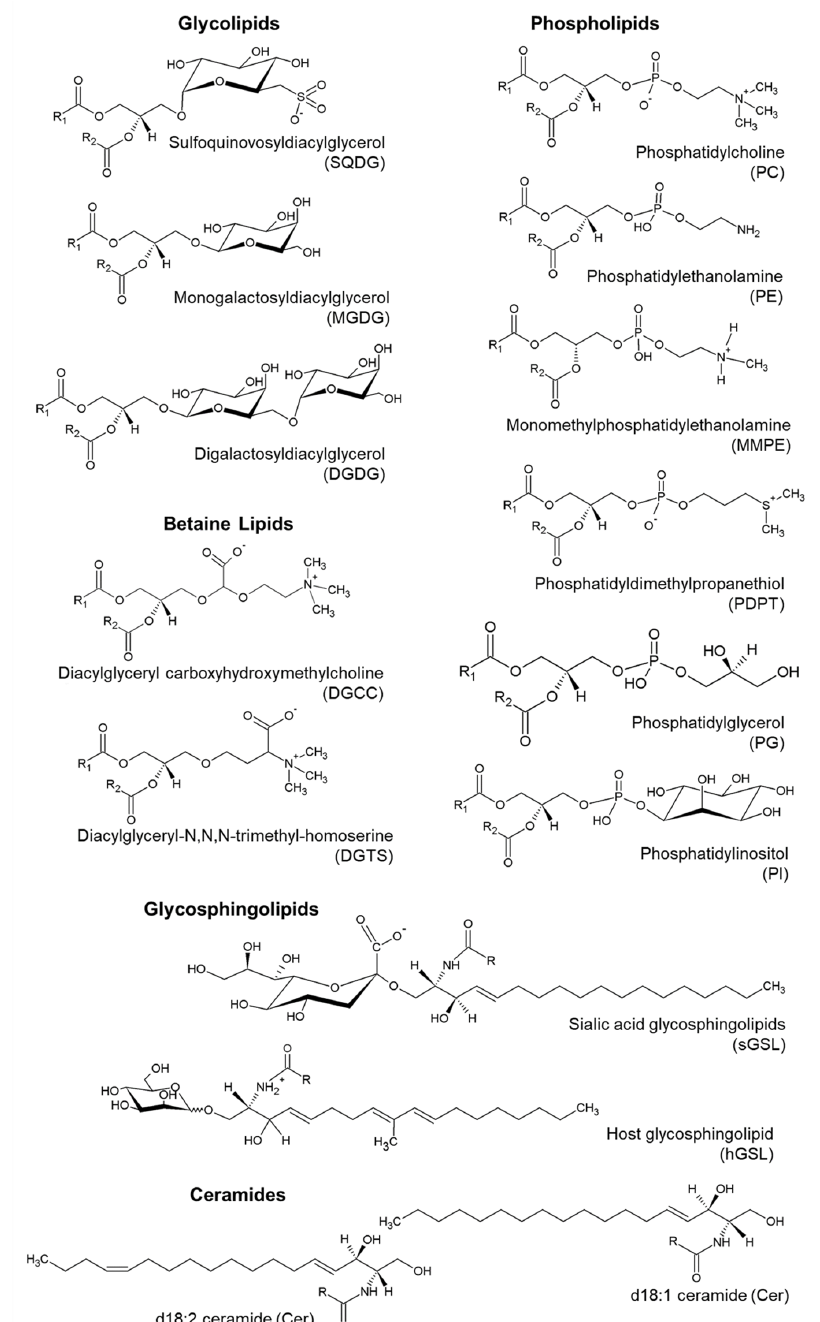
Figure 2. Representative structures of the di ff erent classes of lipids identified in E. huxleyi . Di ff erent species identified in the same class have distinct fatty acyl chains, represented by R 1 and R 2 for the diacyl-forms. The lyso forms have a single fatty acyl